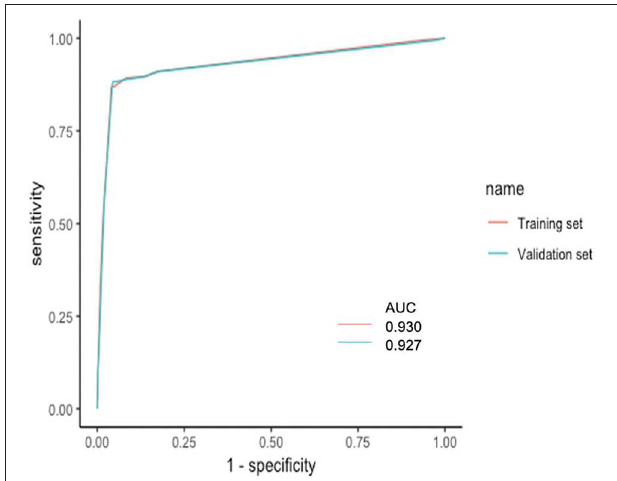
FIGURE 3 | ROC curves of training set and validation set. The x-axis is the “1—Specificity,” and the y-axis is “Sensitivity”. AUCs were also presented with 0.930 and 0.927, respectively. AUC, area under the curve; ROC, receiver operating